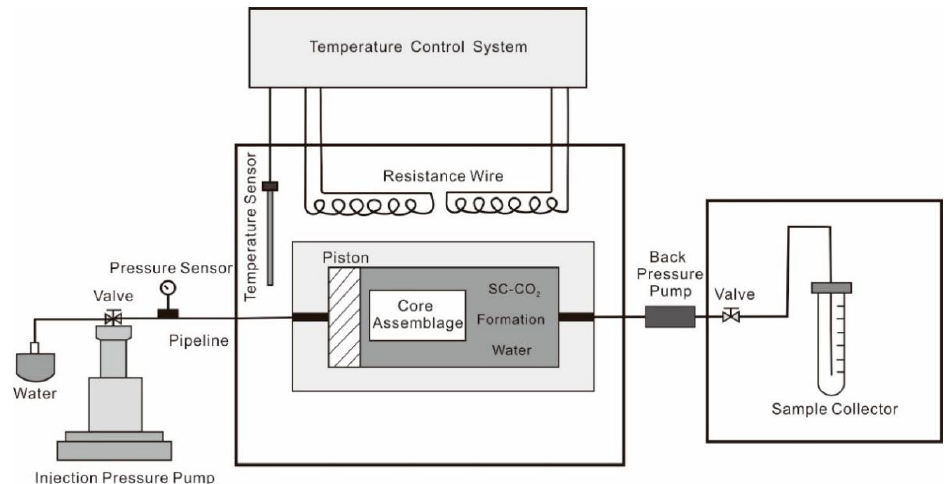
Figure 2. Experimental system setup.